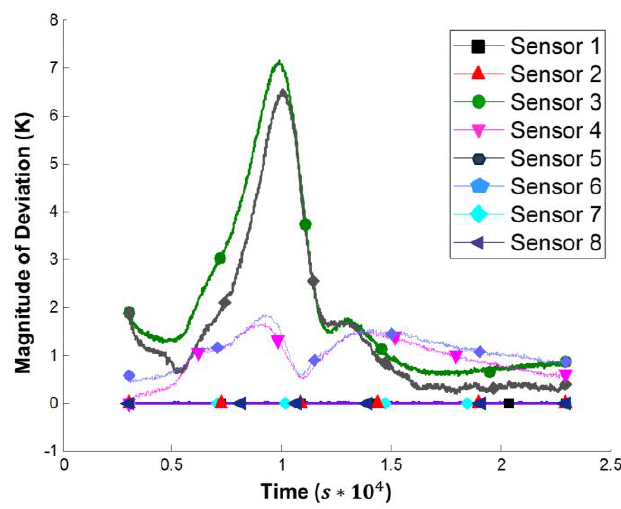
Figure 12. Magnitude of deviation between simulation results and measurement data.